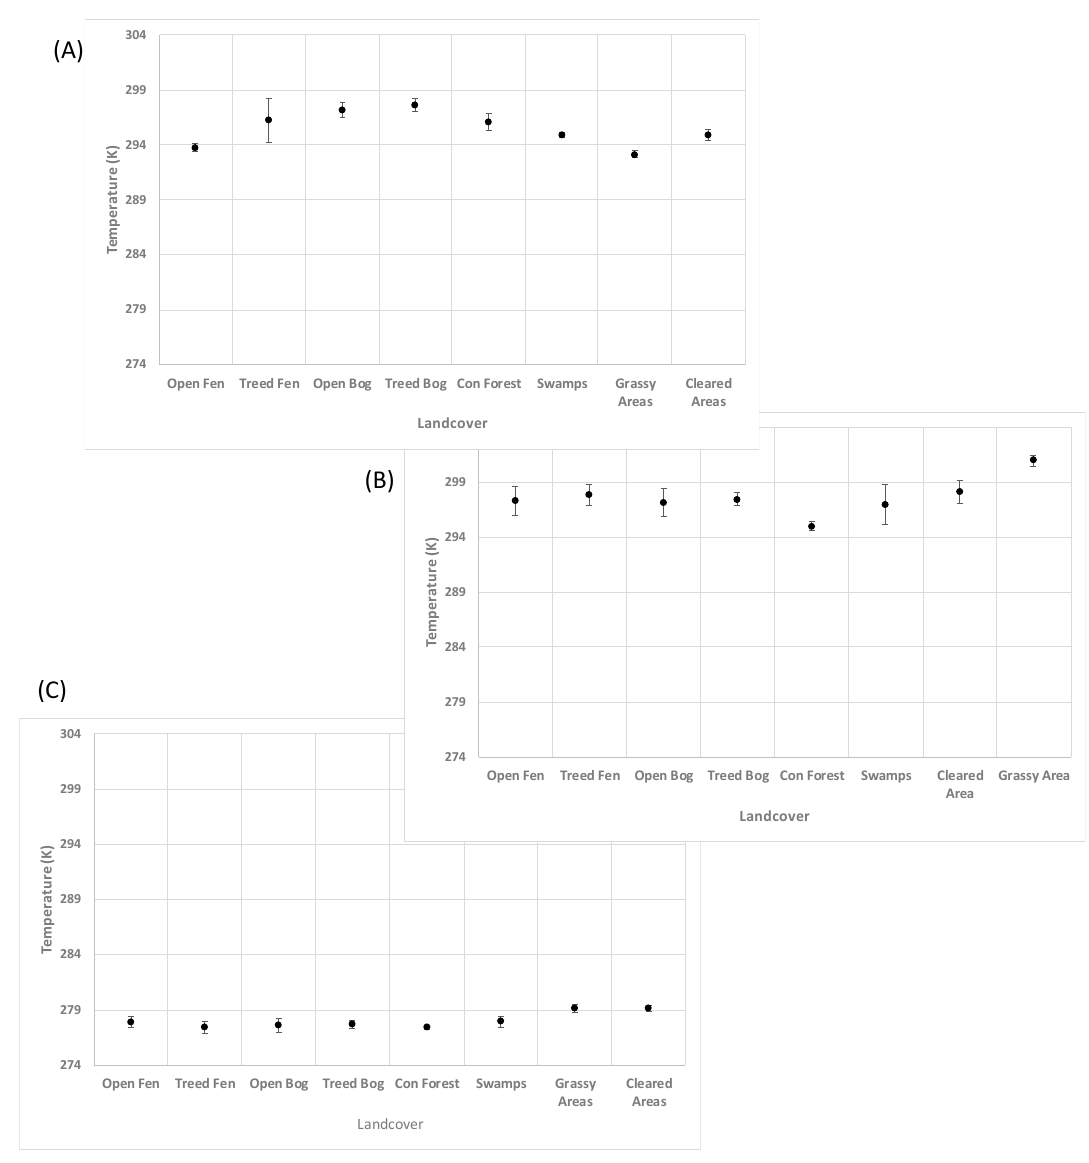
Figure 7. Plots of land covers versus temperature, Error bars represent 1 standard deviation. (A) Spring-1, (B) Summer, (C) Fall-1.